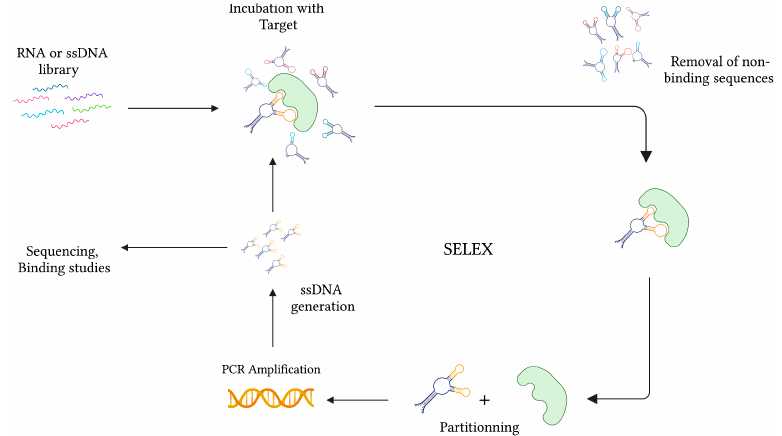
Figure 2. The graphical representation of the SELEX strategy for ssDNA aptamer selection. In the case of RNA aptamer selection, the ssDNA library is first amplified into dsDNA before transcription for RNA synthesis. After collecting the target-specific sequences, RNA is amplified in two consecu- tive steps of reverse-transcription and transcription. Created with BioRender.com (accessed on 19 December 2021).